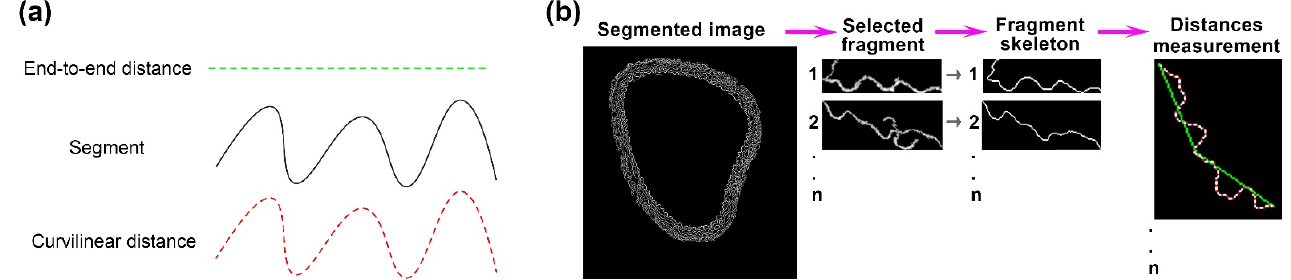
Figure 3. Measurement of the wavy/smooth aspect of the elastic lamellae. ( a ) Scheme illustrating the difference between the end-to-end distance (dashed green line) and the curvilinear distance (dashed red line) for a given segment (black line). ( b ) General view of the process of the quantification of the wavy aspect. Purple arrows indicate the direction of the workflow. First, each segmented image of the stack is thresholded to select individual fragments (1 to n). Each fragment is then skeletonized in a single fragment with two ends. In the rightmost image, each skeleton is subsampled every 3 pixels to reduce pixel discretization error, the curvilinear distance is calculated based on these subsampled points (red), the green line indicates the end-to-end distance.